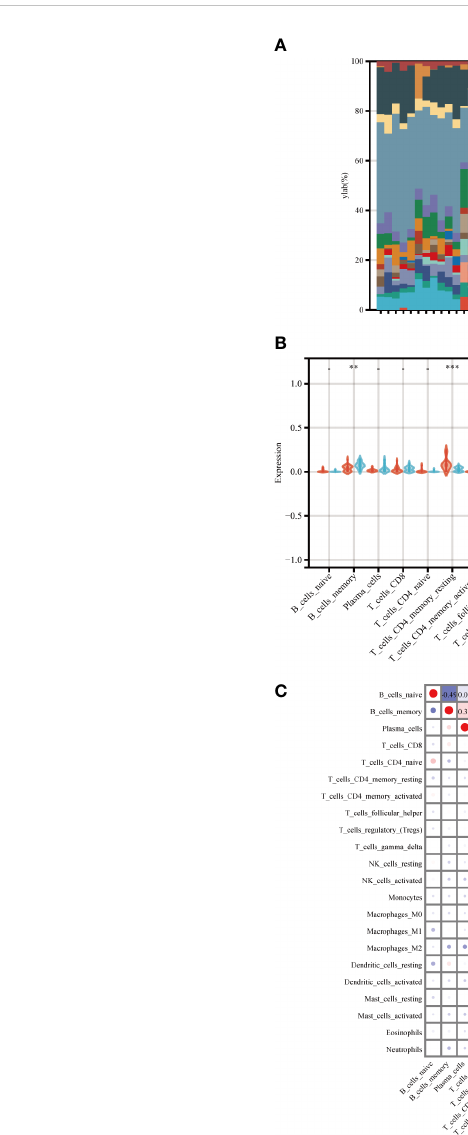
FIGURE 8 Immune cell in fi ltration analysis between OA and control. (A) The proportion of 22 kinds of immune cells in different samples visualized from the burplot. (B) Comparison regarding the proportion of 22 kinds of immune cells between OA and control groups visualized by the vioplot. (C) Correlation of 22 immune cell type compositions, *,p < 0.05, **,p < 0.01, ***,p < 0.001. Both horizontal and vertical axes demonstrate immune cell subtypes OA,